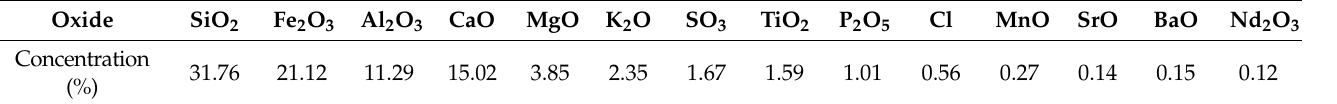
Table 1. Oxide composition of fly